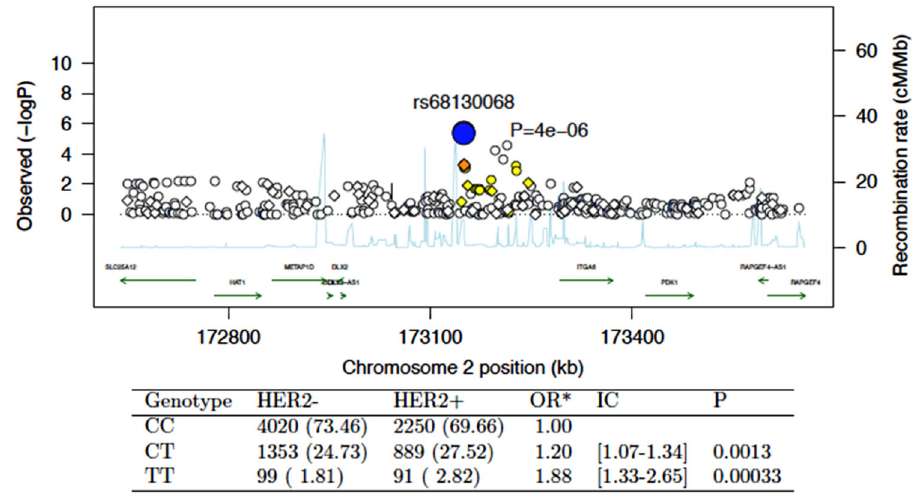
Fig. 4 LocusView 1 plot of SNP with the strongest association with HER2 status. Adjusted for age and the two fi rst component of the